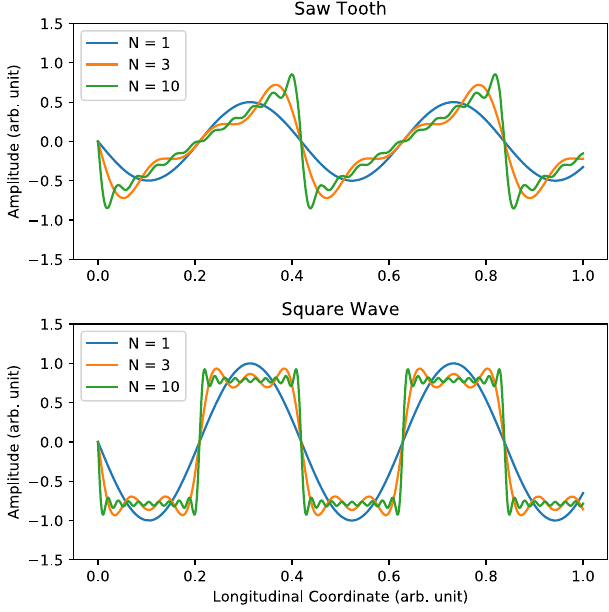
FIG. 3. Plot of amplitude vs longitudinal coordinate for an arbitrary sawtooth modulation [Eq. (8)] and an arbitrary square wave modulation [Eq. (9)] for N ¼ 1 , N ¼ 3 and N ¼ 10